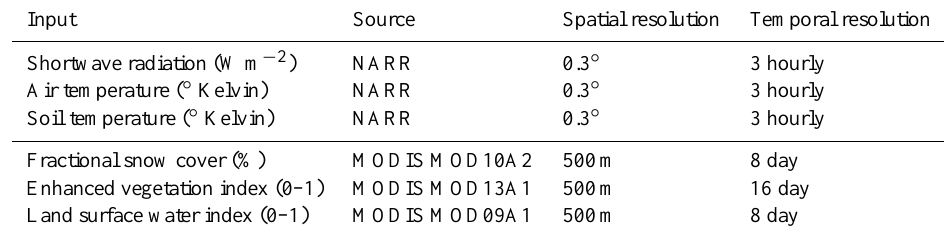
Table 2. Summary of meteorological and land surface remote-sensing inputs to PolarVPRM.